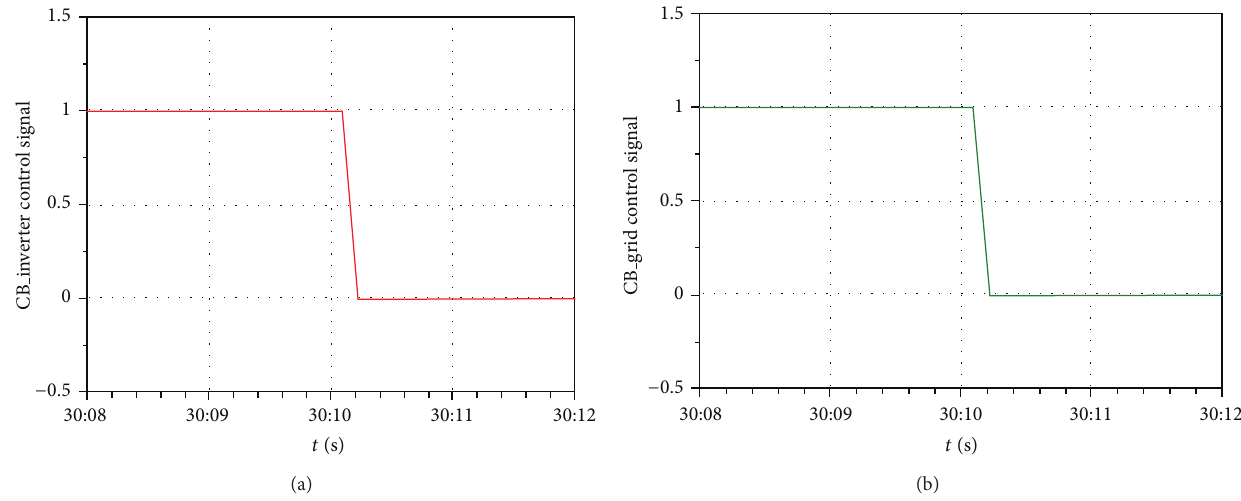
Figure 19: Control signals of circuit breakers for under frequency condition.